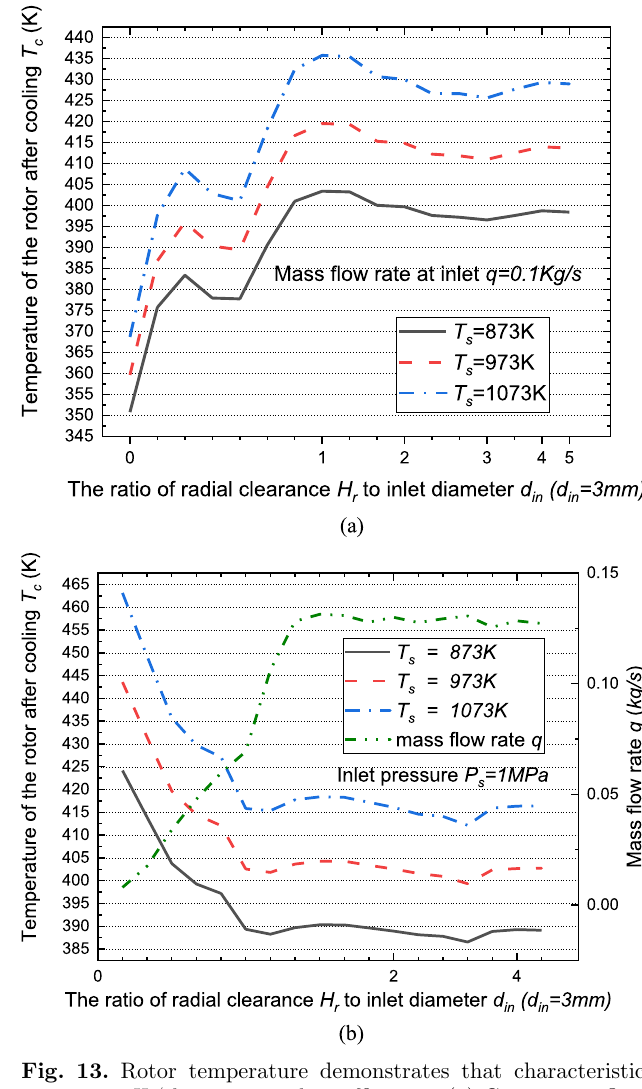
Fig. 13. Rotor temperature demonstrates that characteristic parameter H r / d in versus cooling ef fi ciency, (a) Given mass fl ow ( q = 0.1kg/s) of nozzle, (b) Given pressure (1 MPa) of